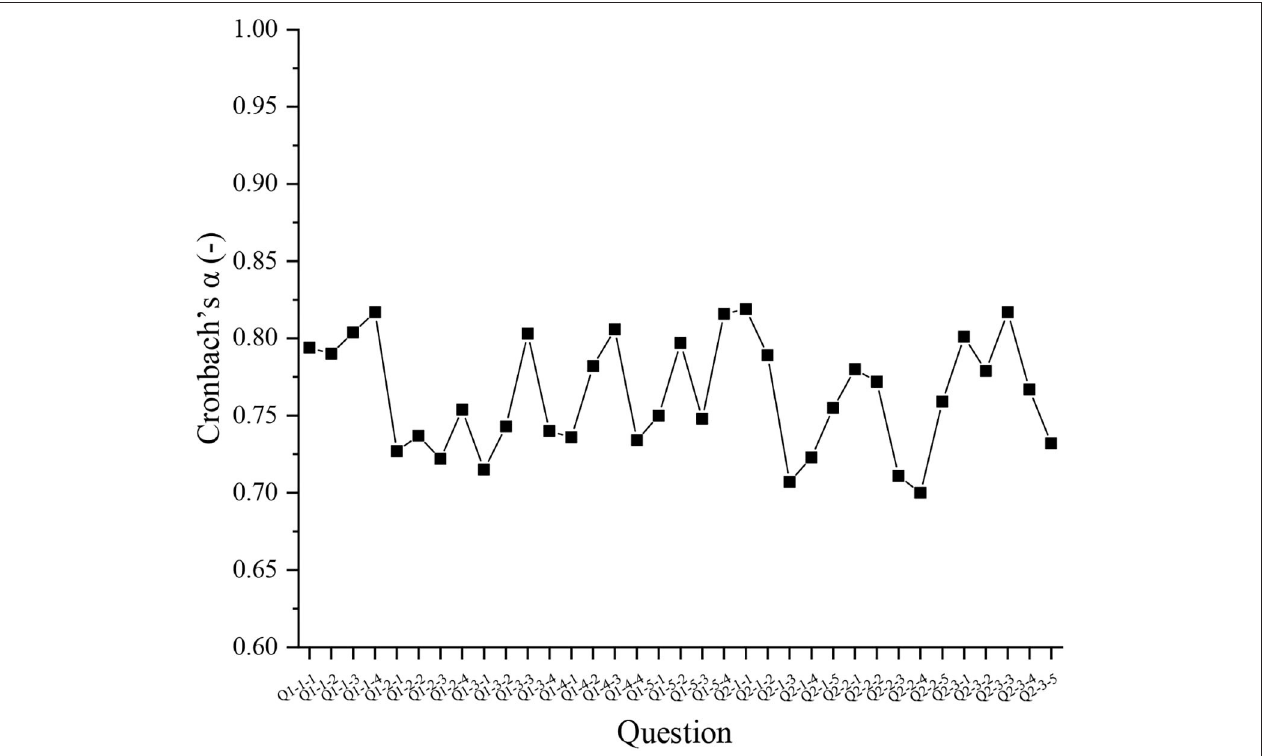
FIGURE 2 | Reliability analysis of the questionnaire survey (QS) scales.